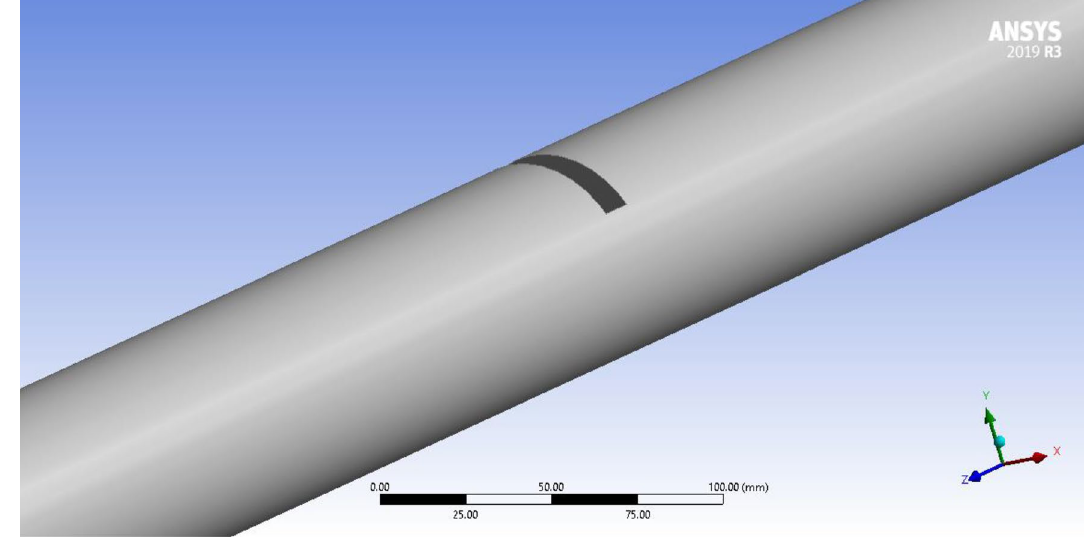
Fig. 8 Model of pipe with gate